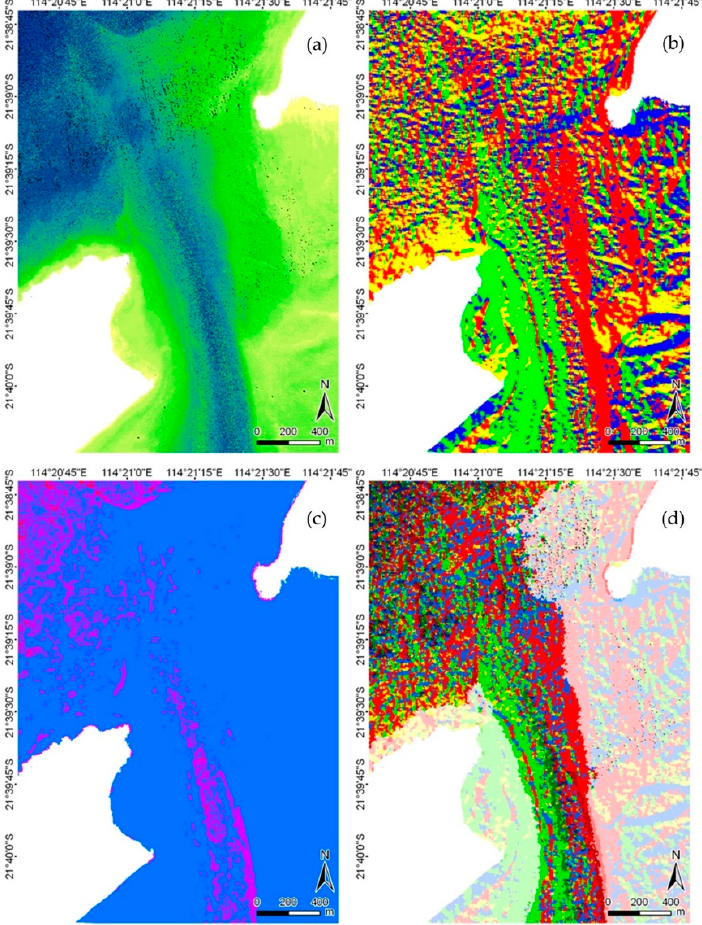
Figure 7. Topographic variables for the focus area at Muiron Islands at the northern extent of the Ningaloo Reef. ( a ) depth, ( b ) aspect, ( c ) slope, and ( d ) topographic classification. Legends in Figure 6 apply.